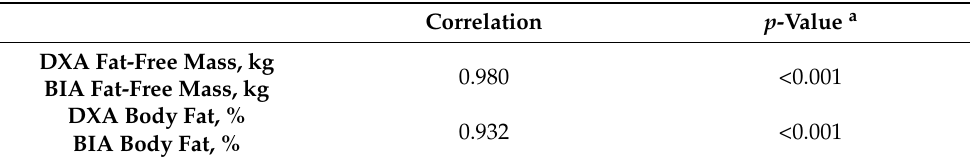
Table 3. Correlation between fat-free mass and body fat was analyzed by the two methods studied (BIA and